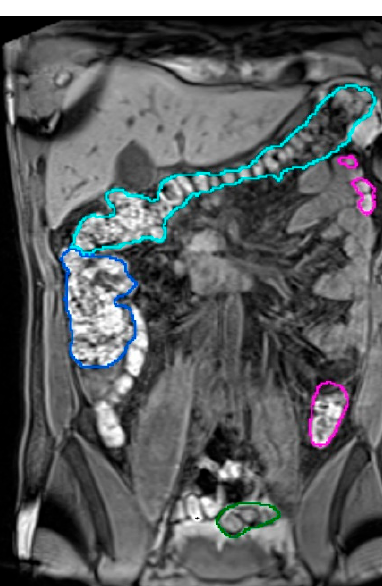
Figure 4. Comparison of segmentation results (in blue) with a ground truth manual colon segmenta- tion (in green) in T2 images. In the left image, the red arrow marks a small ileum region wrongly assigned to colon by the automatic algorithm. In the right image, a highly challenging area even for the specialists (outlined in red) is shown. Courtesy of [7].